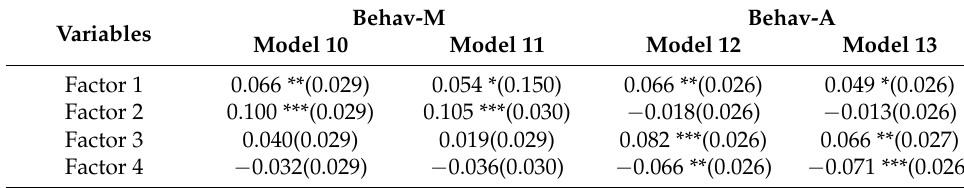
Table 6. The robustness check of the